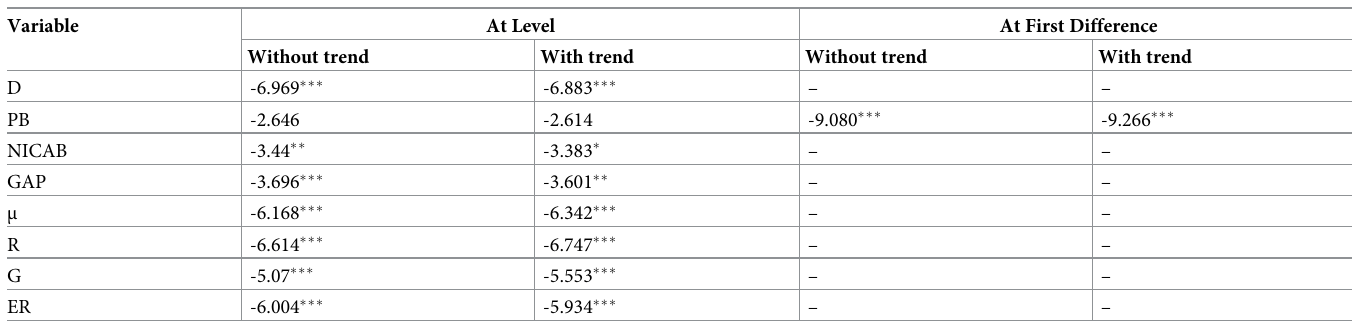
The descriptive statistics for all the variables of the model are reported in Table 3. The important observation from these descriptive stats is that none of the series deviate from nor- mal distribution except for interest rate. However, non-normality of any regressor is not a con- cern as the sum of random variables tends to be normal (Central Limit Theorem). Further, the errors of the model follow the assumption of normality (Table 7). Correlation matrix (Table 4) indicates that some of the regressors have significant association. However, keeping in mind the time series data properties, these correlations are not threatening as far as multicollinearity is concerned. The variance inflation factor (VIF) values for all variables are less than the bench- mark value- five which indicates no problem of multicollinearity (Table 4, last column). On balance, these statistics suggest that the estimated parameters would be unbiased, consistent, and efficient.